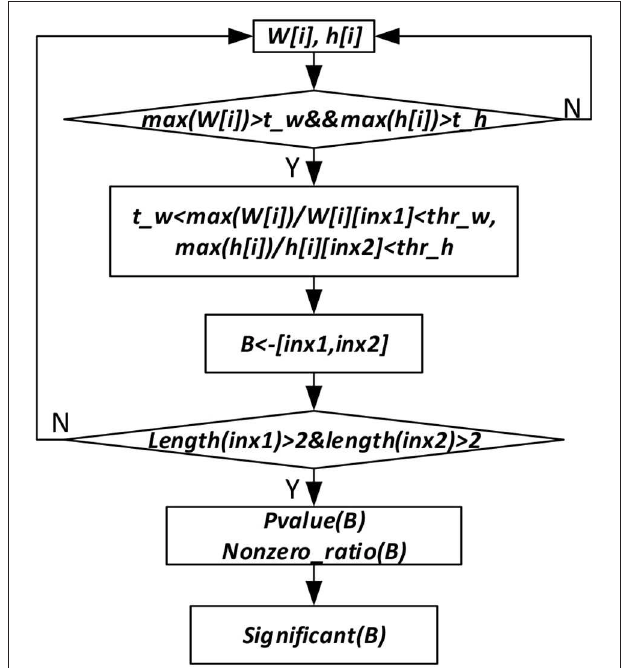
FIGURE 2 | Significant bicluster extraction process. W [ i ] and h [ i ] are the gene and sample membership vectors. max ( W [ i ]) and max ( h [ i ]) are maximum values of W [ i ] and h [ i ], respectively. t_w , t_h , thr_w, and thr_h are threshold values used to filter bicluster membership genes and samples. B represents bicluster. P-value ( B ) is p -value of a bicluster B . Nonzero_ratio ( B ) is used for bicluster quality control, which is calculated as the ratio of non-zero elements in a